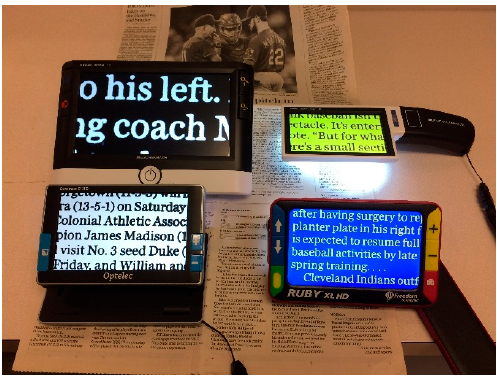
Figure 14. Handheld electronic magnifiers.